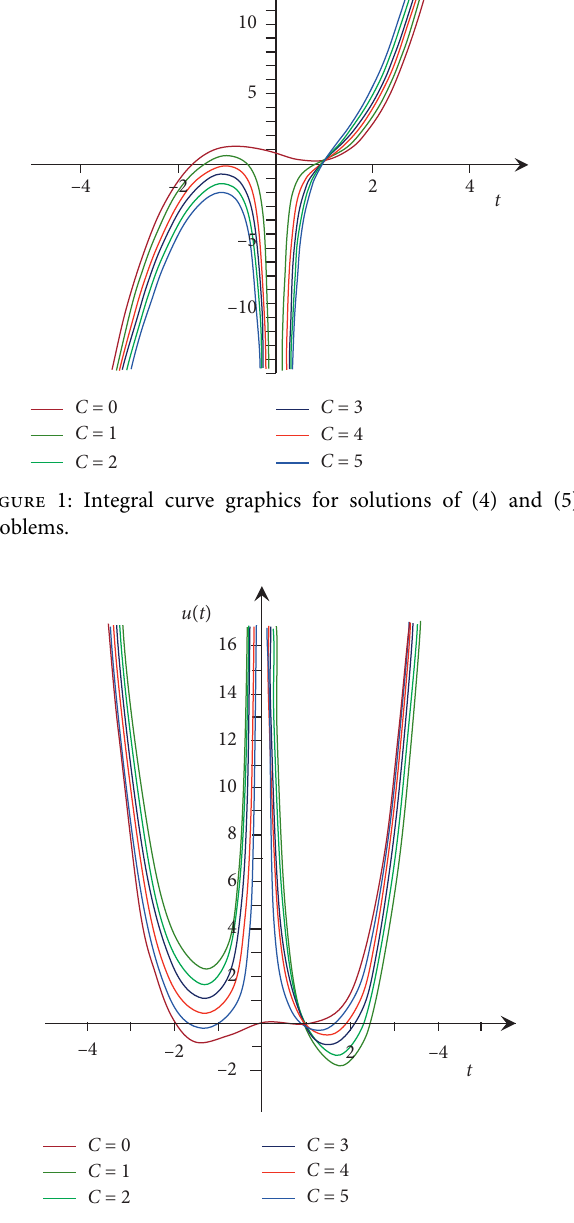
Figure 2: Integral curve graphics for solutions of (4) and (5)